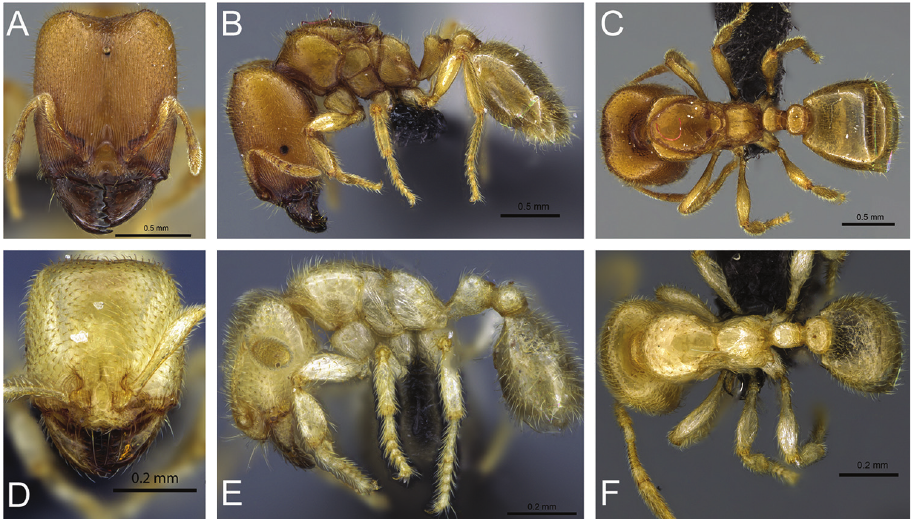
Figure 57. Carebara placida –holotype. Major worker, CASENT0070818: A head in full-face view B body in profile view C body in dorsal view. Minor worker, CASENT0070817: D head in full-face view E body in profile view F body in dorsal